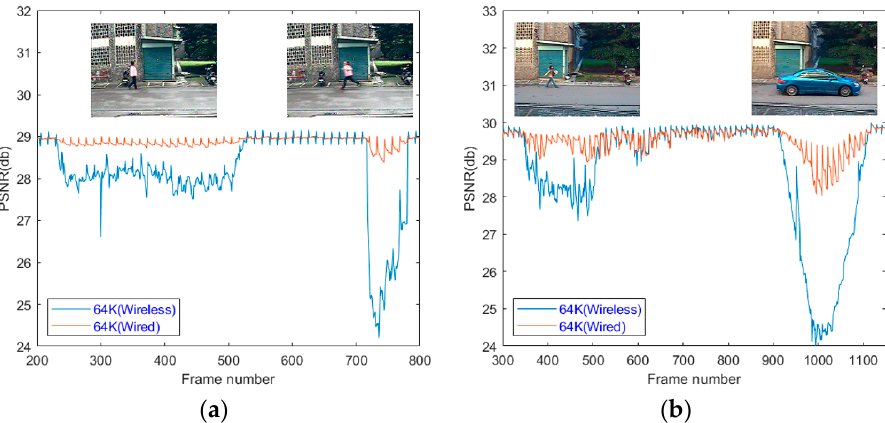
Figure 1. Degraded video quality with respect to object and network conditions: ( a ) moving objects with different speeds and ( b ) moving objects with different sizes.